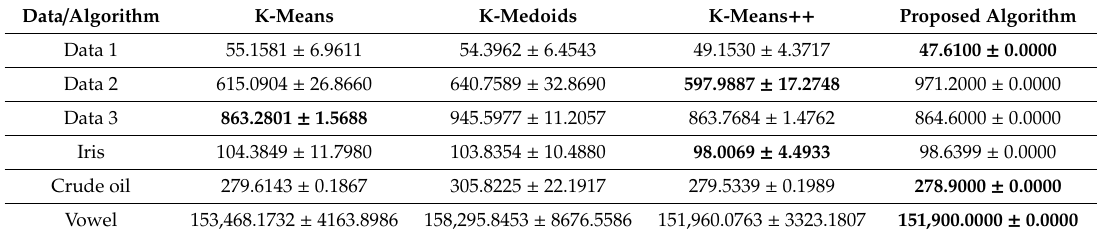
Table 2. Clustering results on the used